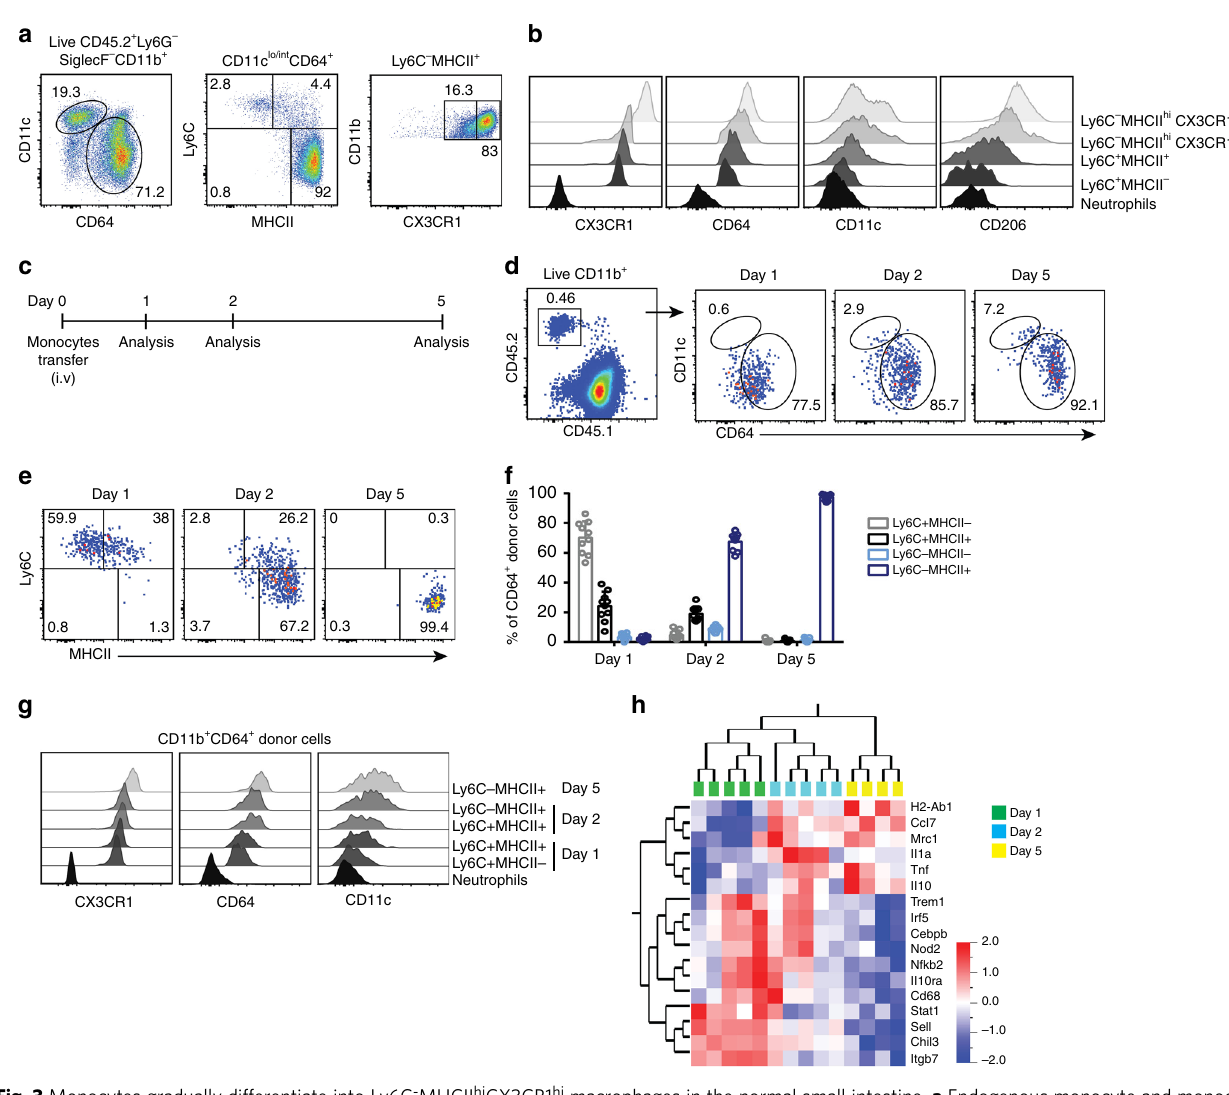
Fig. 3 Monocytes gradually differentiate into Ly6C - MHCII hi CX3CR1 hi macrophages in the normal small intestine. a Endogenous monocyte and monocyte- derived cells in the small intestinal lamina propria (siLP) were identi fi ed as Ly6G − SiglecF − CD11b + CD11c lo/int CD64 + leukocytes (MNP CD64 + cells). MNP CD64 + cells were further divided into four subpopulation based on expression of Ly6C, MHCII, and CX3CR1/GFP; namely Ly6C + MHCII − , Ly6C + MHCII + , Ly6C − MHCII hi CX3CR1 int , and Ly6C − MHCII hi CX3CR1 hi . b Representative histograms demonstrating expression of CX3CR1, CD64, CD11c, and CD206 on subpopulations shown in a and neutrophils (CD11b + Ly6G + ) for comparison. c Schematic illustration of the experimental setup for d – g . Puri fi ed monocytes were adoptively transferred to recipient mice and donor cells were recovered from siLP at day 1, 2, and 5 after transfer. d Donor MNP CD64 + cells recovered from siLP of the recipients were identi fi ed by congenic markers followed by gating as described in left panel of a . e Representative FACS plots demonstrating donor MNP CD64 + cells that gradually lost expression of Ly6C and gained expression of MHCII from day 1 to day 5 after transfer. f Frequency of Ly6C- and MHCII-de fi ned subsets among donor MNP CD64 + cells in the intestine at the indicated time points. Data were pooled from at least 4 independent experiments with a total of 9 – 10 mice each. g Expression of CX3CR1/GFP, CD64, and CD11c on indicated subsets of donor MNP CD64 + cells at day 1, 2, and 5 post-transfer compared to endogenous neutrophils. Results in g are representative of 4 independent experiments each. h Heat map showing hierarchal clustering of gene expression pro fi les of adoptively transferred MNP CD64 + cells. Donor monocyte-derived cells were recovered from siLP of recipient mice at day 1, 2, or 5 after transfer and transcriptomic analysis was performed by nanostring nCounter analysis. Differentially expressed genes were determined by Qlucore Omics explorer with a statistical signi fi cance p -value of 0.05. Data were pooled from 2 – 3 independent experiments with a total of 4 – 5 mice for each time